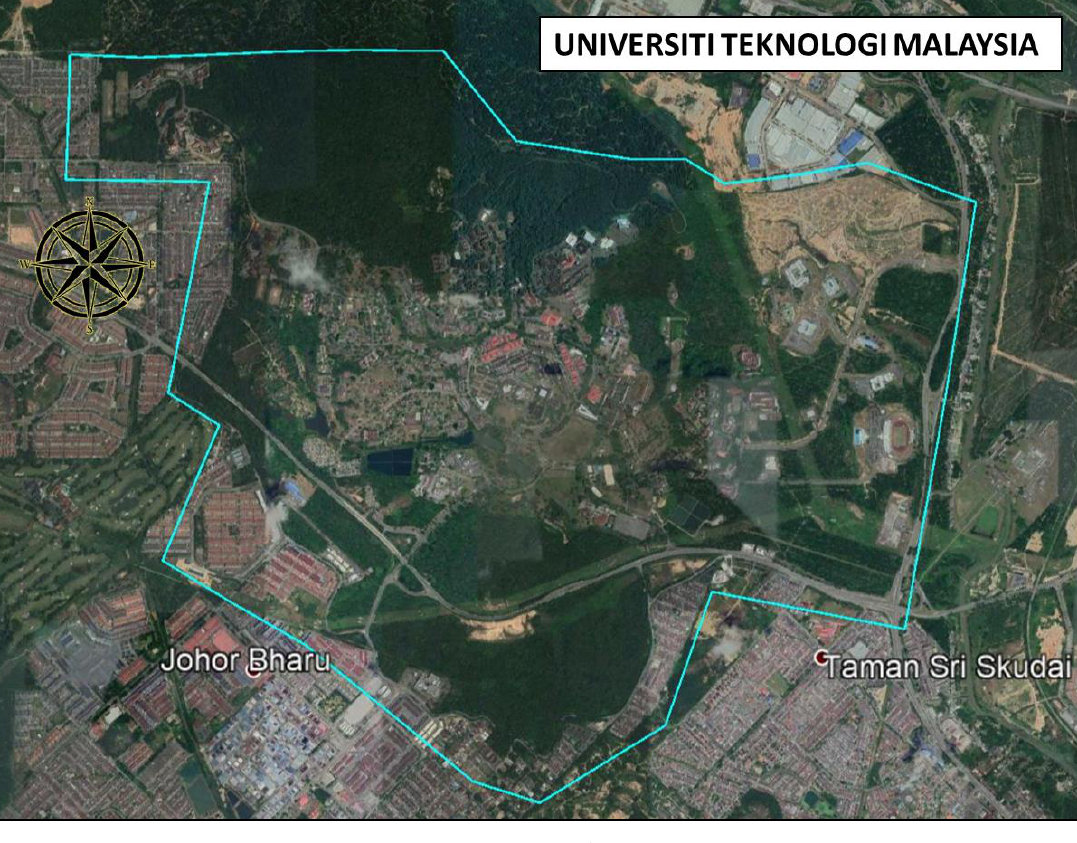
Figure.1 Location of the study area.